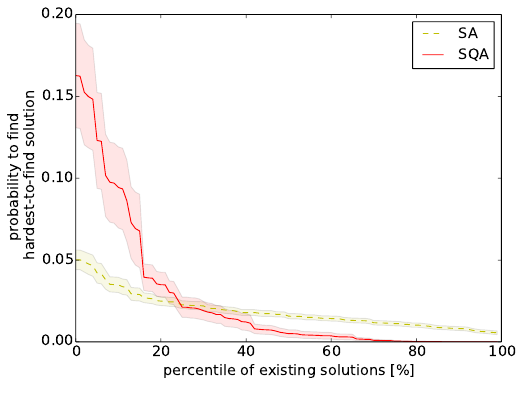
Figure 15: Average probability to find the hardest-to-find solution among the most often found percentile of all existing solutions. The average is taken over 20 randomly generated 5-SAT instances with a clauses-to-variables-ratio of α χ